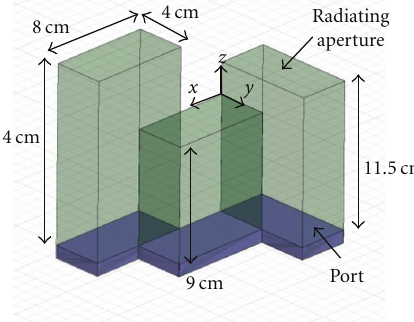
Figure 4: EM simulation model of three open-ended waveguides radiating into empty space, operating at 3GHz. Each waveguide consists of four perfectly conducting walls, an excitation port, and a radiating aperture. The model was simulated using HFSS with perfectly matched layer (PML) boundaries in the far